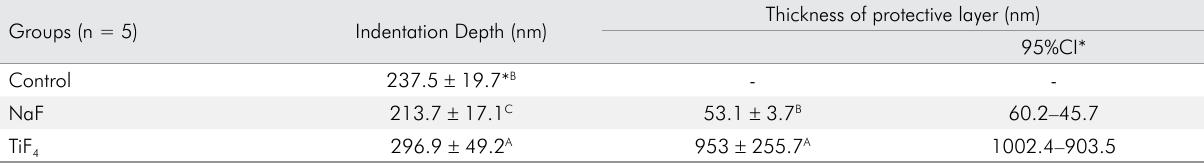
Table 3. Depth of indentation and thickness of protective layer formed by varnishes after erosive challenge. Groups (n =